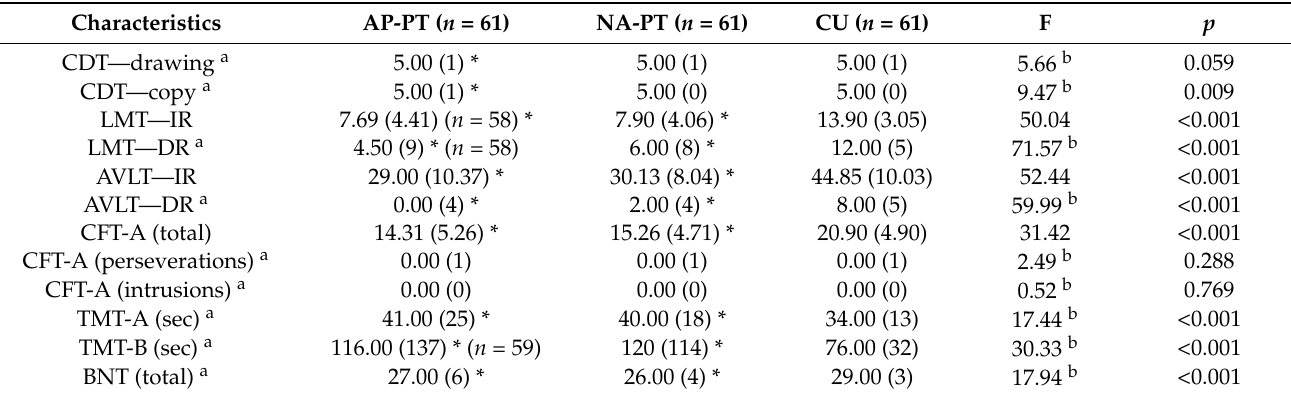
Table 3. Differences in cognitive performance across participant groups. Values are means and standard deviations unless otherwise